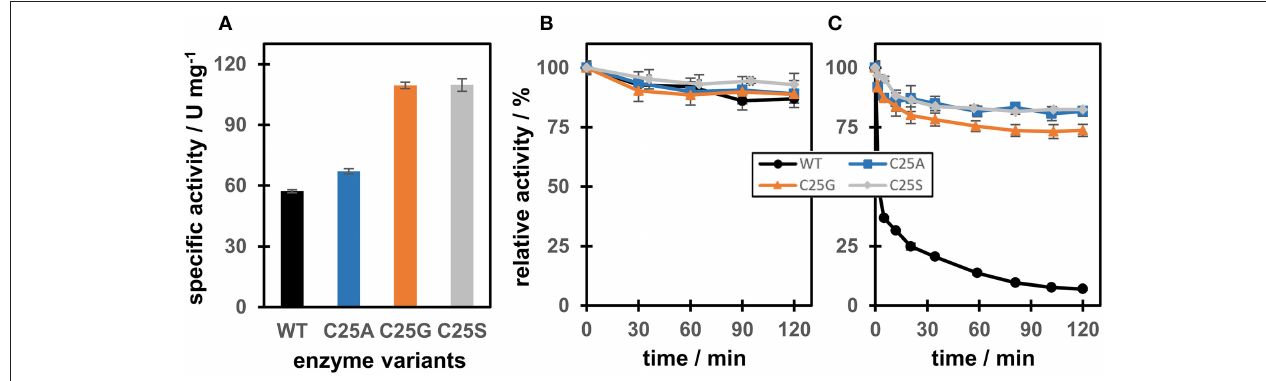
FIGURE 3 | Specific activity and time-dependent inactivation of OYERo2a WT and Cys variants with N -methylmaleimide. (A) Specific activities using N -methylmaleimide as a substrate. (B) Relative activity of WT and variants after incubation for 120min in 50mM KH 2 PO 4 /Na 2 HPO 4 buffer pH 7.1 at 4 ◦ C (in the dark). Samples were taken at several time points to measure enzyme activity. (C) Relative activity of WT and variants after incubation for 120min with 10mM N -methylmaleimide in 50mM KH 2 PO 4 /Na 2 HPO 4 buffer pH 7.1 at 4 ◦ C (in the dark). Samples were taken at several time points to measure enzyme activity.